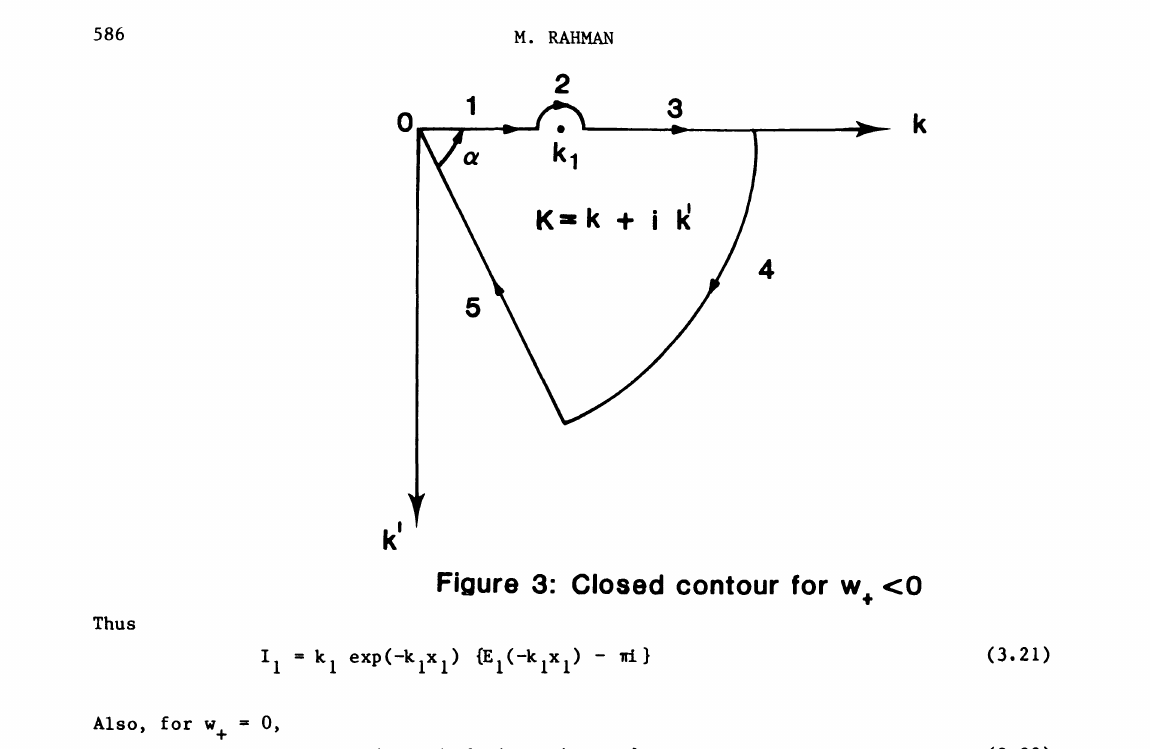
Figure 3: Closed contour for w,